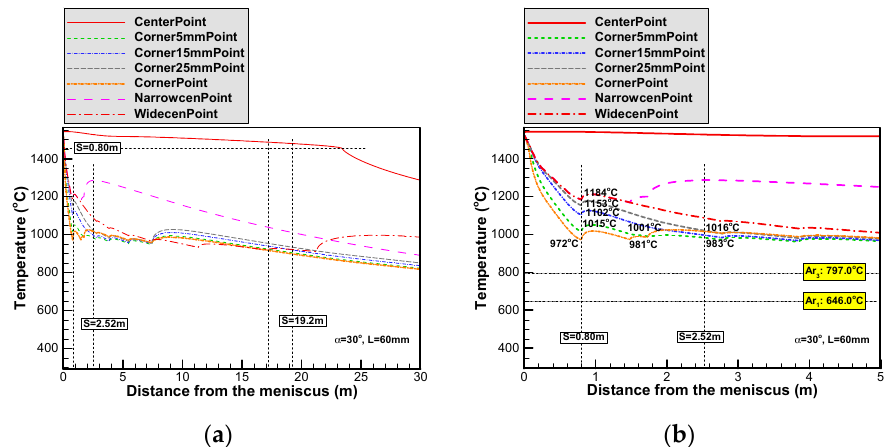
Figure 13. Temperature distribution under weak cooling in foot roller zone of the chamfered slab. ( a ) The whole process of slab solidification, ( b ) enlarged view of mould and bending section. Table 6. Comparation of temperature of chamfered slab under intensive and weak cooling (°C). Intensive Cooling Chamfered slab